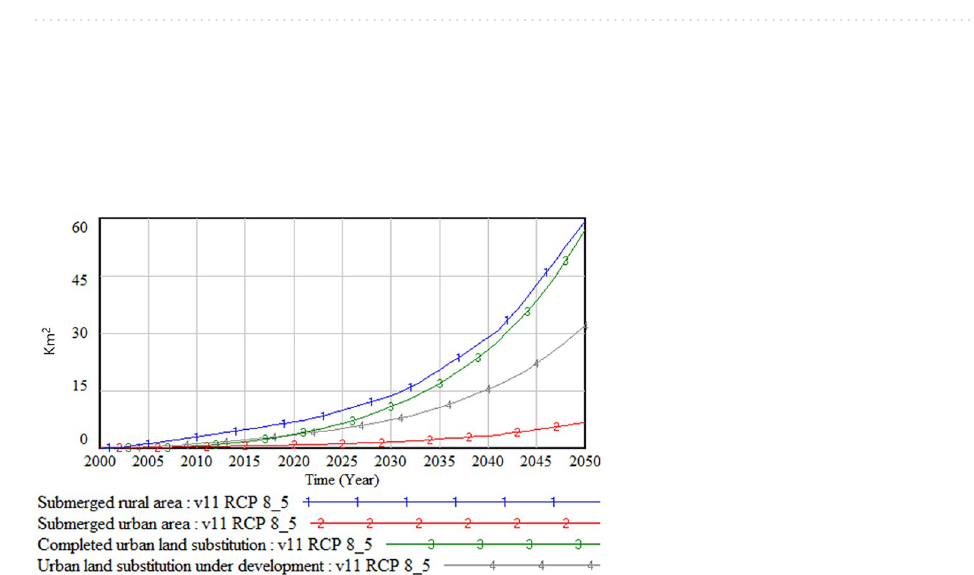
Figure 4. Total damage and damage in each area from climate change. Unit on the vertical axis: billions of Korean won (1 US dollar = approximately 1,100 Korean won).